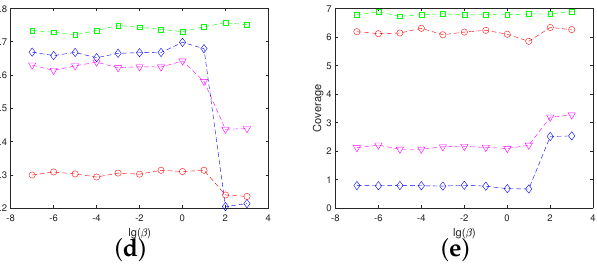
Figure 8. Sensitivity analysis of parameter β on four data sets for five evaluation metrics.